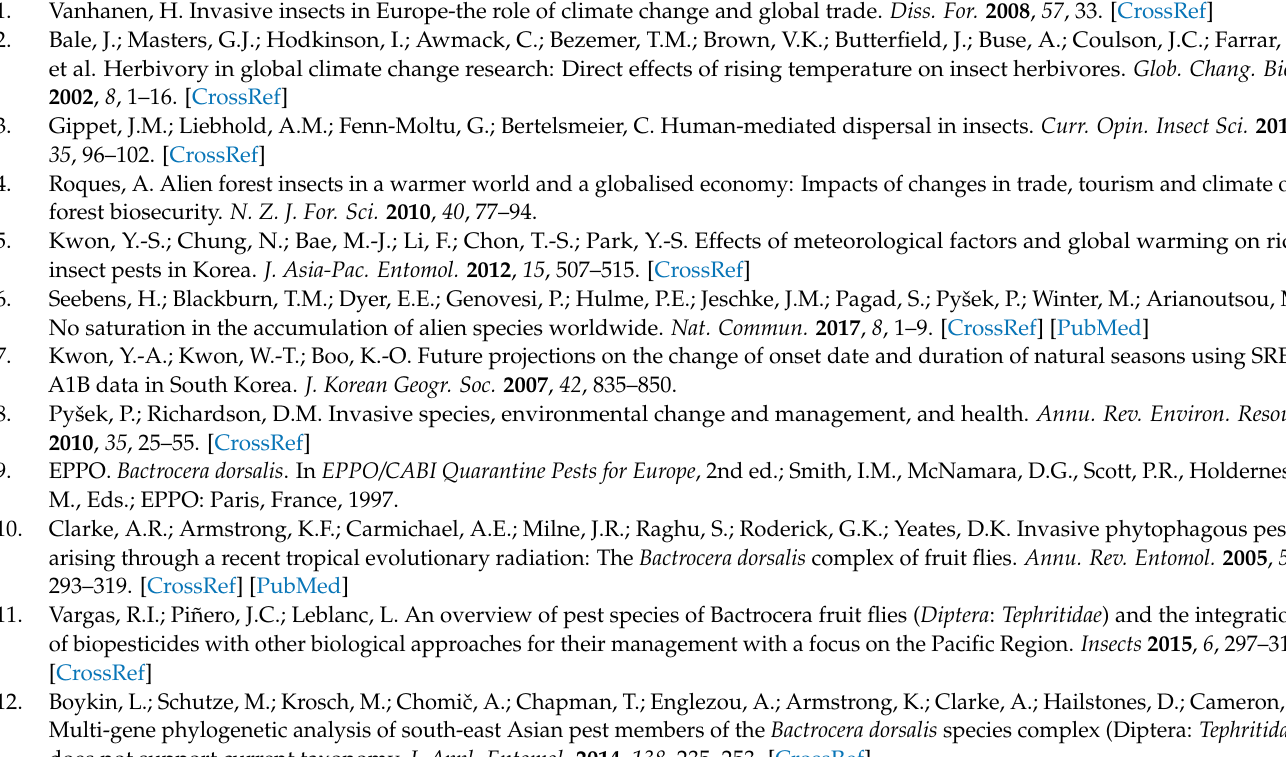
table. Table S7: Allelic frequencies based on the polymorphisms of 15 microsatellite markers at each study